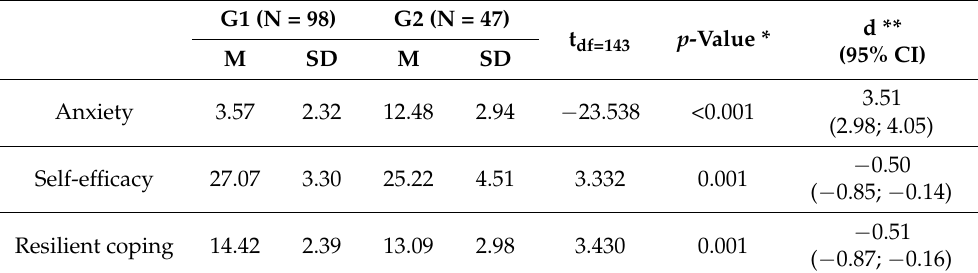
Table 2. G1 and G2 group profiles.